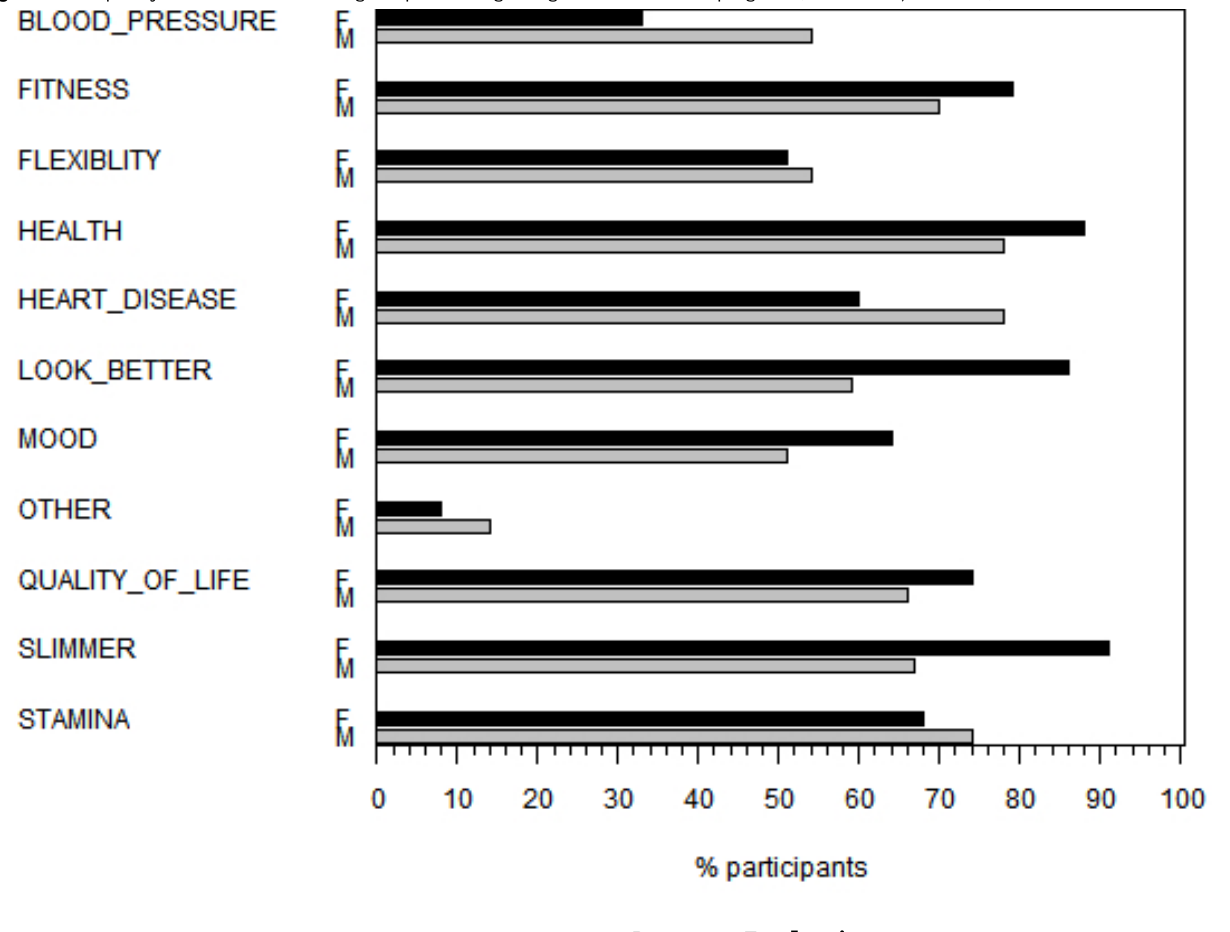
Figure 8. Frequency of choice of the listed goals prior to beginning the 12-week Web program (F = women, M =